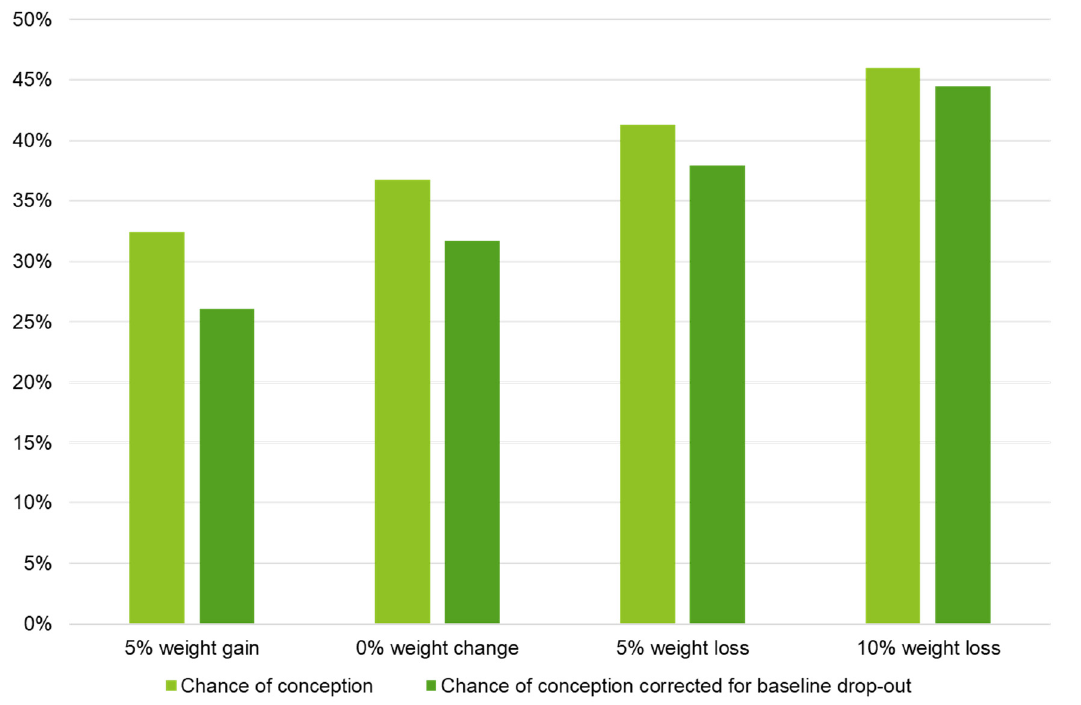
Figure 3. Logistic regression model for the effect of changes in weight on the chance of conception ≤ 24 months after the start of the intervention resulting in live birth. Note: Results are based on calculations by the Erasmus MC using non-public microdata from Statistics Netherlands. Logistic regression analyses; chance of conception: B = − 0.038 SE 0.028, p = 0.169; chance of conception corrected for baseline drop-out: B = − 0.055 SE 0.031, p = 0.081.